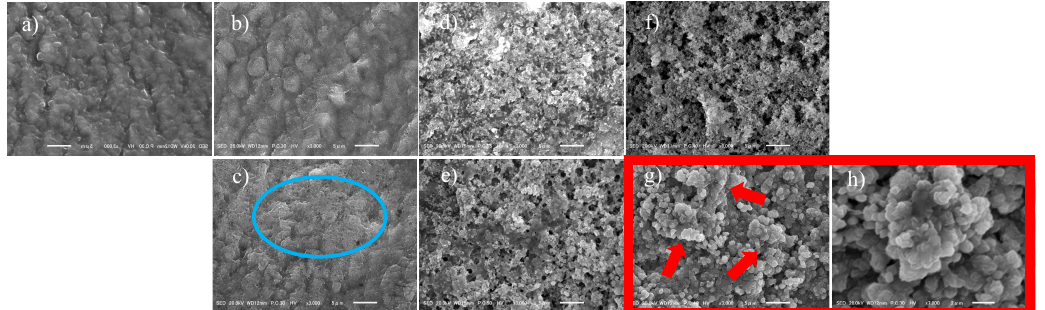
Figure 4. The SEM images before priming after using primer.(CLEARFIL SE BOND 2 Primer and experimental calcium-containing primer) at each storage time. ( a ) before priming(×3000). ( b ) after CLEARFIL SE BOND 2 Primer of the immediately group (×3000). ( c ) after experimental calcium containing primer of the immediately group(×3000). ( d ) after CLEARFIL SE BOND 2 Primer of the 1 month storage time group (×3000). ( e ) after experimental calcium containing primer of the 1 month storage group (×3000). ( f ) after CLEARFIL SE BOND 2 Primer of the 6 months storage time group (×3000). ( g ) after experimental calcium-containing primer of the 6 months storage group (×3000). ( h ) higher magnification of ( g ) (×7000). Table 3. The mean value of rate (%) of elemental composition before priming and at each storage time point after priming (immediately,1 month, and 6